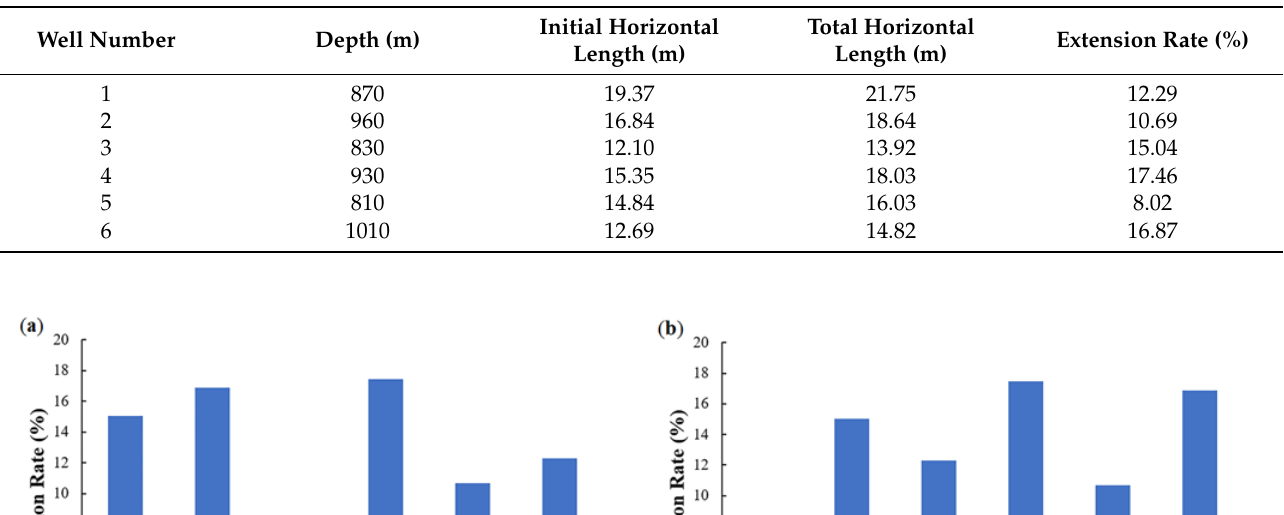
Table 3. Results of DFDR-based URHW drilling field trials.